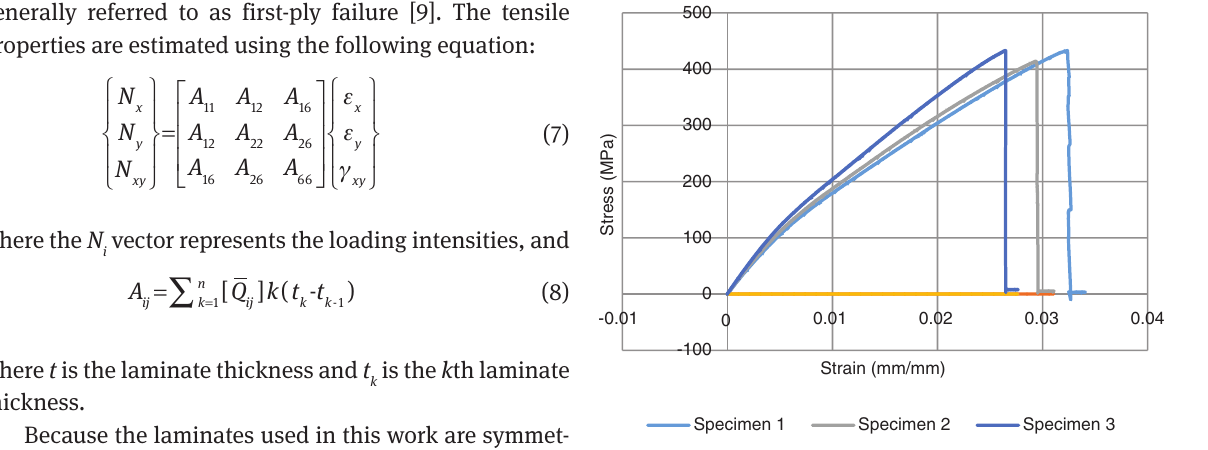
, 0 ] specimens. 4 4 s